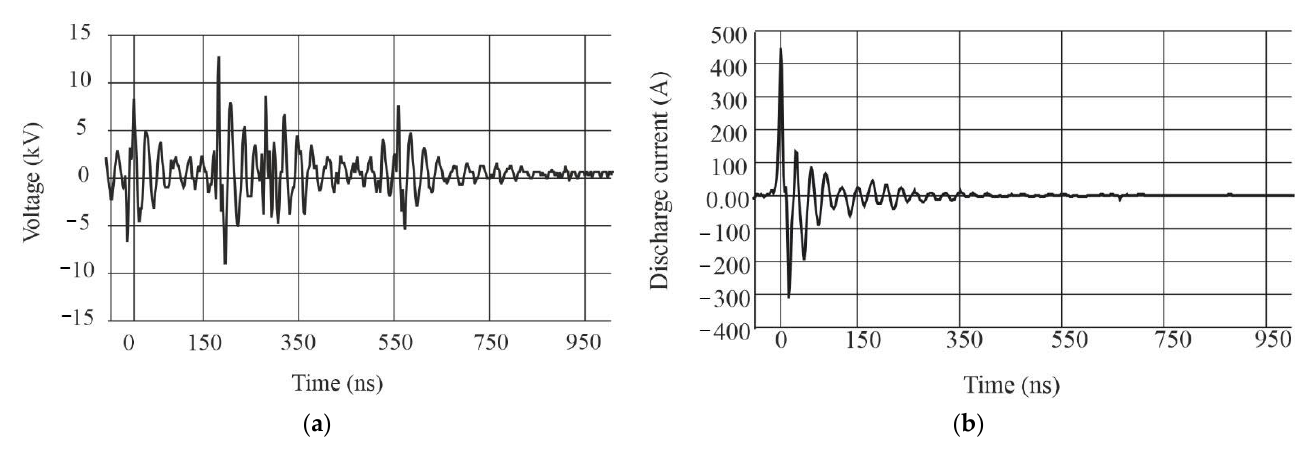
Figure A2. Oscillograph records characterizing no-load voltage ( a ) and discharge current ( b ) of DBD impulse.